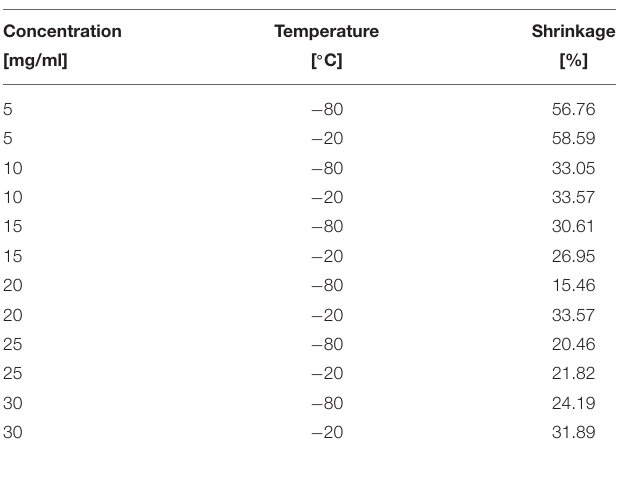
TABLE 2 | Shrinkage of the sponges in different silk concentration and temperature.